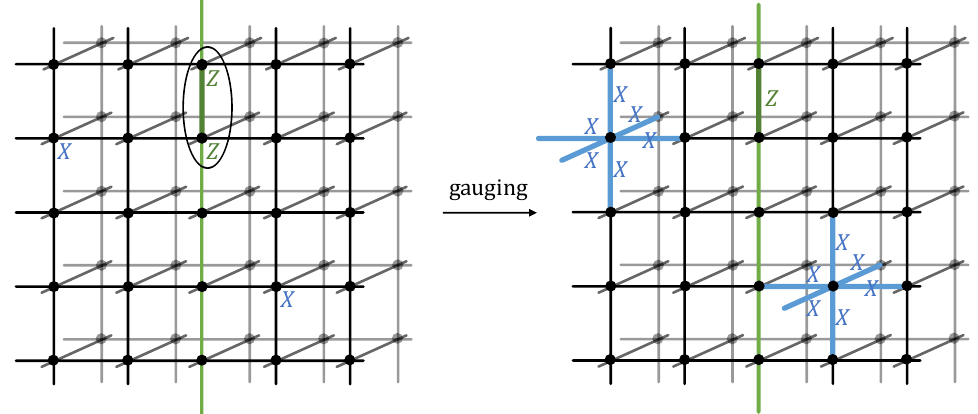
Figure 40: The Cheshire string is obtained by gauging the (3 + 1)D trivial invertible phase with (cid:90) symmetry, with a decoration of the (cid:90) 2 on the 1d defect line (green